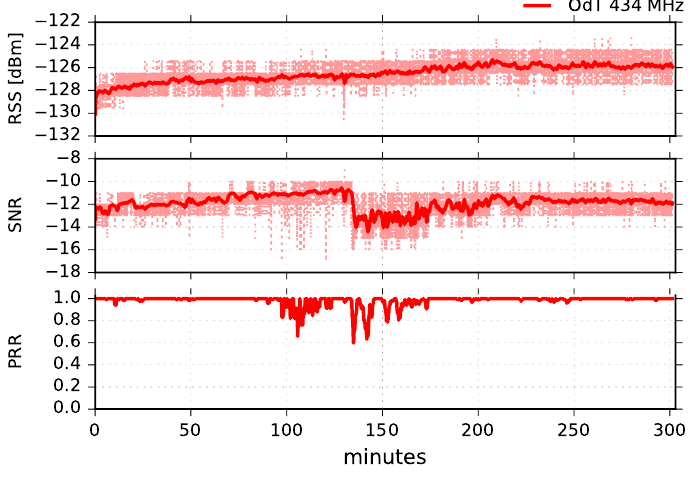
Figure 21. RSS, SNR, and PRR for ODT at 434MHz in obstructed path for BW = 125kHz, SF = 10, and CR =